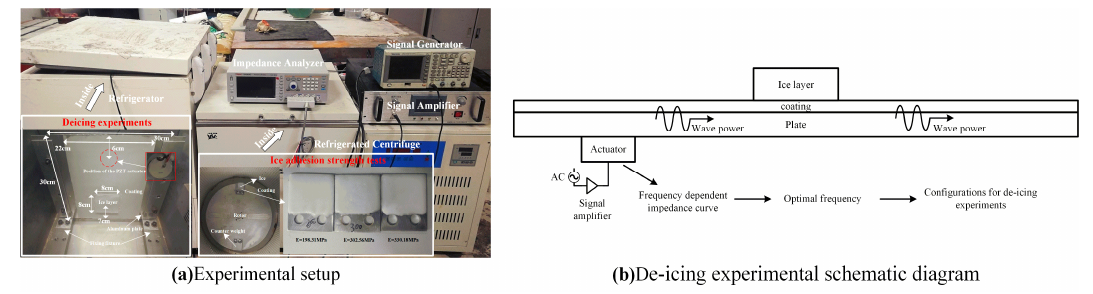
Figure 13. Experimental setup and de-icing experimental schematic diagram.